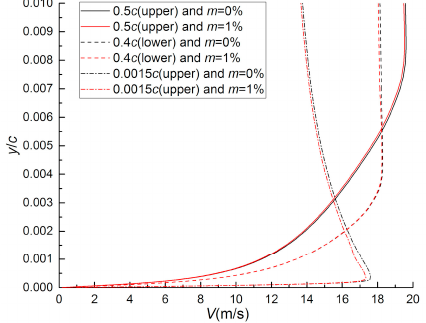
Figure 7. Velocity profiles for S809 airfoil flow at α = 4.1° and Re = 1.5 × 10 6 .